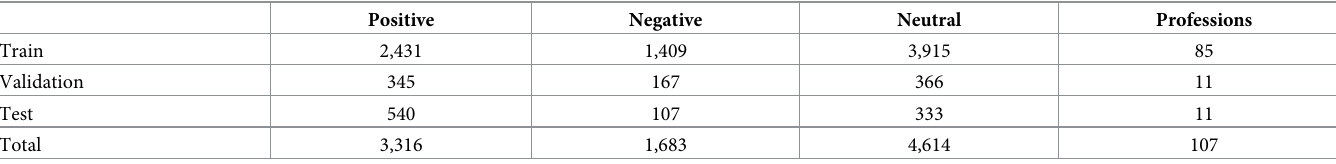
Table 2. Sentiment-annotated professional mentions